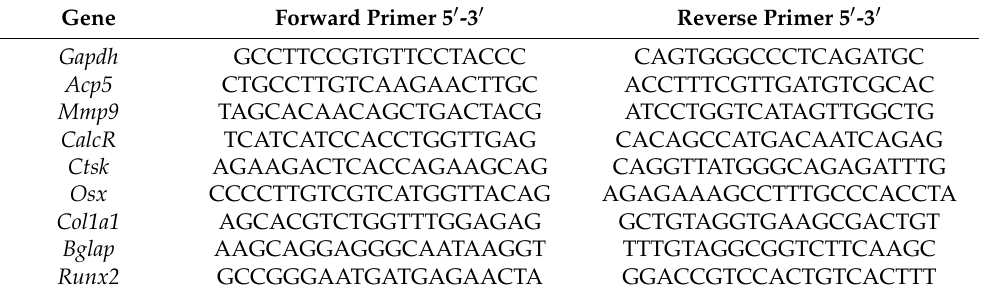
Table 1. List of primers used in real-time PCR.